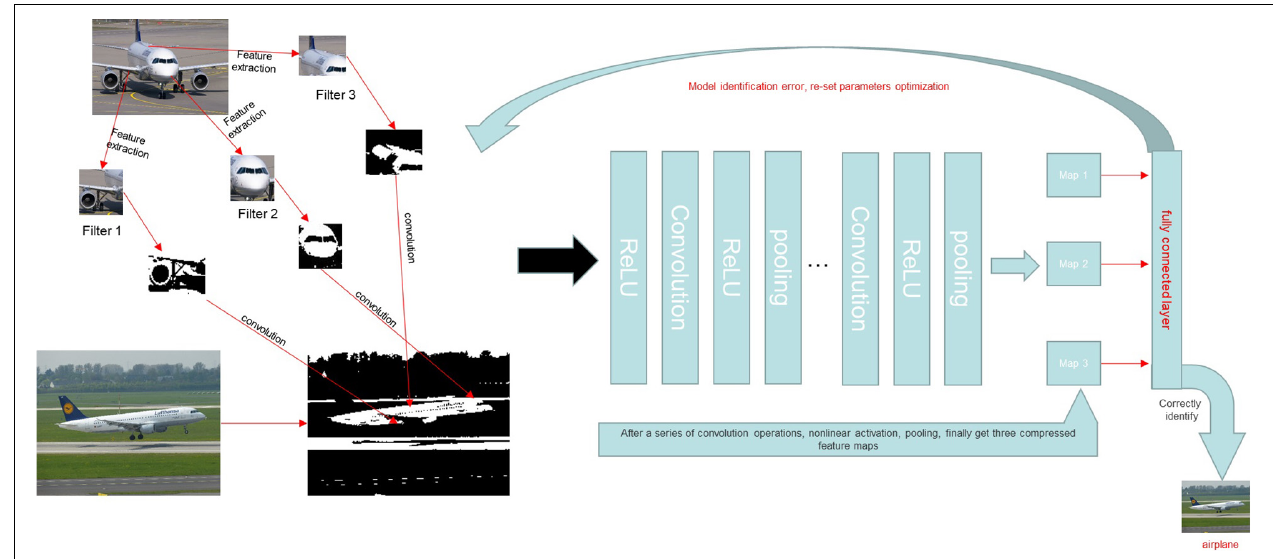
FIGURE 10 | A CNN model was trained to identify whether or not the content of a given picture was an airplane. We assumed that the characteristics of the aircraft were the tail, engine, and fuselage and set the characteristics as the convolution kernel. The image was then converted into a matrix that a computer could recognize. The eigenmatrix of the sample was obtained by a convolution operation between the convolution kernel and the sample image. A non-linear activation function was then used to perform a non-linear activation operation on the eigenmatrix to improve the sparsity of the network and reduce the interdependence of parameters. The pooling layer was used to reduce the dimension of the feature matrix, compress the image features, remove the redundant information, and reduce the amount of calculation. Finally, we converted the calculated eigenspace mapping sample marker space into a one-dimensional vector through the full connection layer to obtain the complete image features. After completing the above steps, we also established an error function to determine the accuracy of the output. The convolution kernel parameters were adjusted to reduce the error and obtain the actual features of aircraft